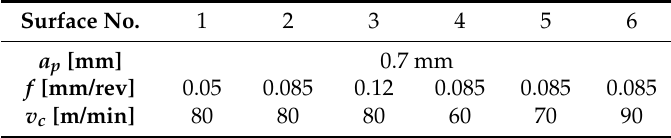
Figure 4. The workpiece with six machined spherical surfaces ( a ); and surfaces roughness measurement after turning ( b ). Table 3. Experimental design of variables.